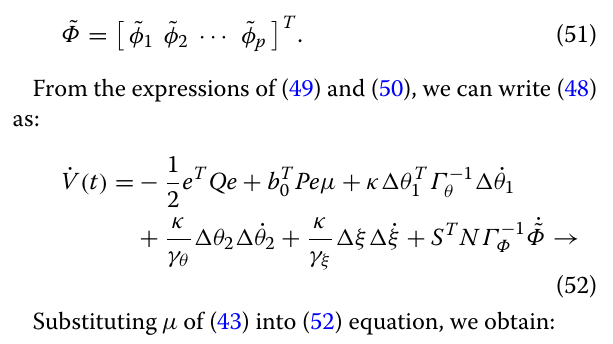
Substituting (54) into (56), we obtain: